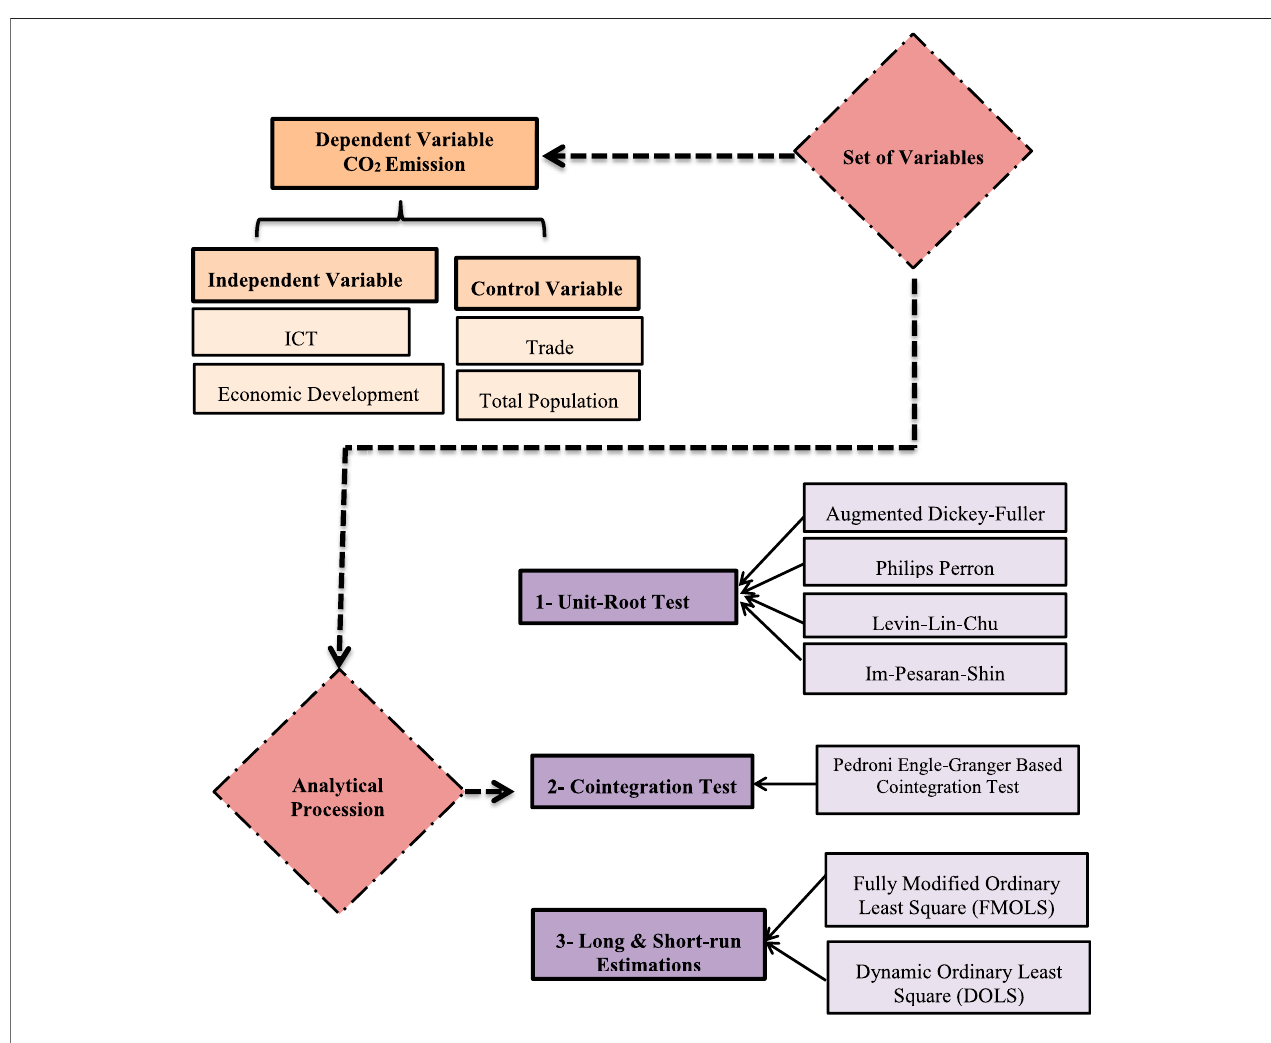
FIGURE 1 | Flowchart of variables and analytical